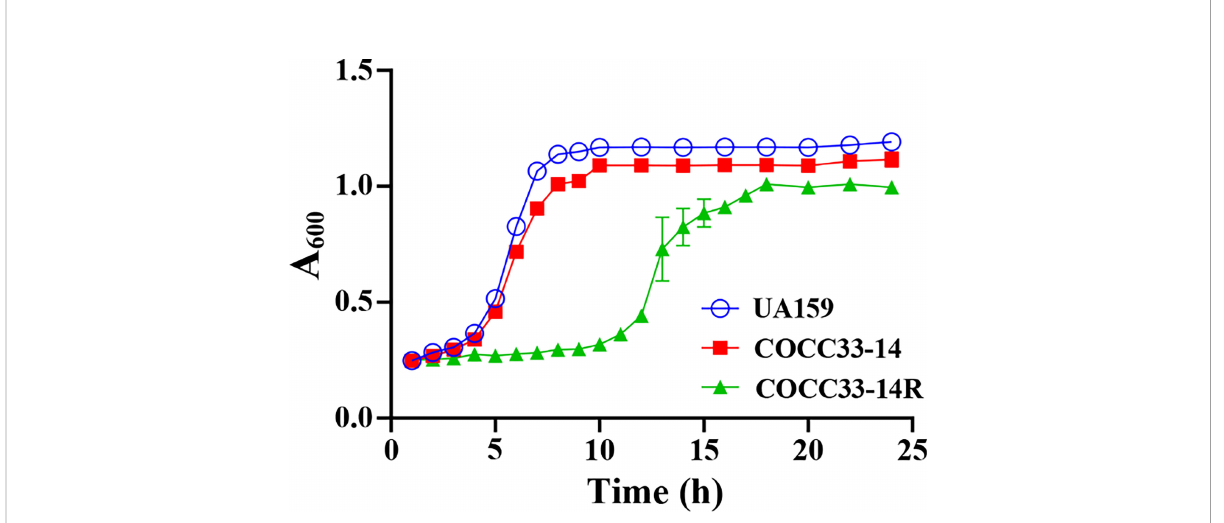
FIGURE 3 Kinetic growth curves (mean ± SD; n = 3). UA159: S. mutans UA159; COCC33-14: S. mutans COCC33-14 parental strain; COCC33-14R: GH12- resistant S. mutans COCC33-14